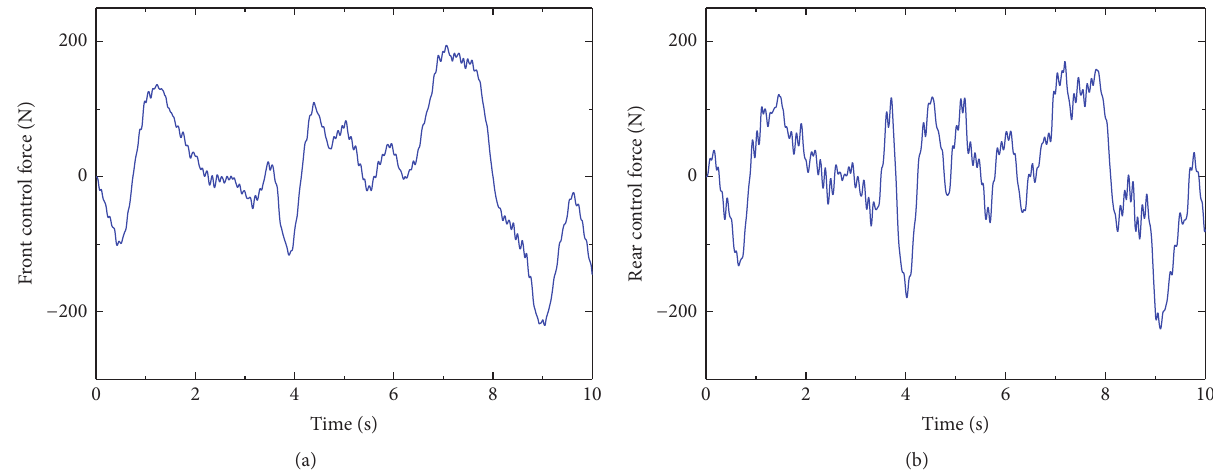
Figure 5: Simulation results of the active controllable force for the front and rear